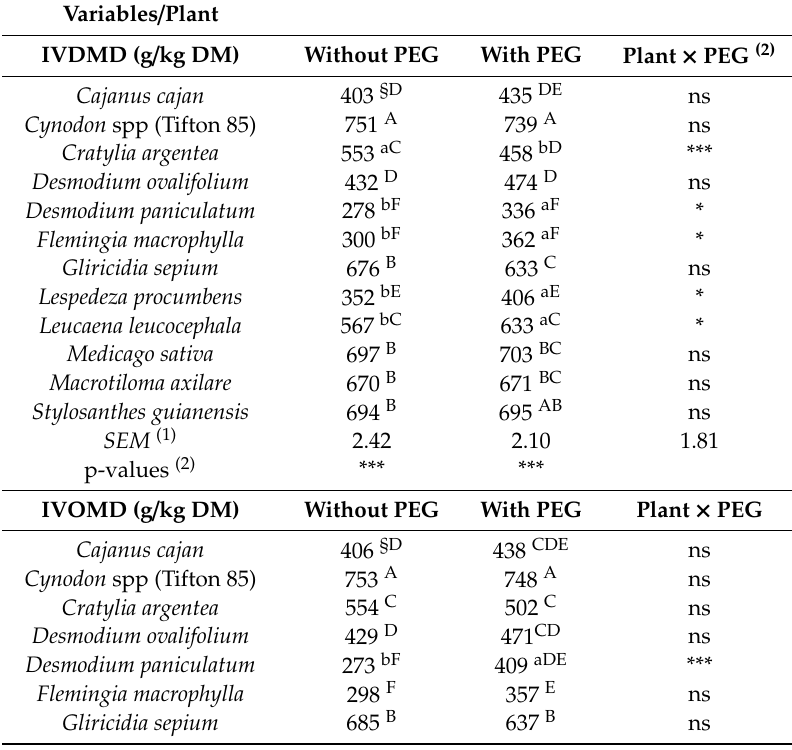
Table 1. E ff ects of tannins from plant species on ruminal degradability, microbial e ffi ciency and N -NH 3 at 96 h of incubation in